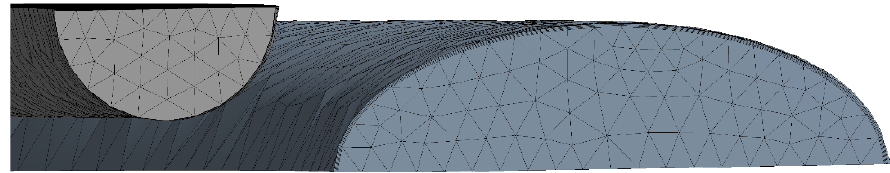
Figure 8. Grid partition.